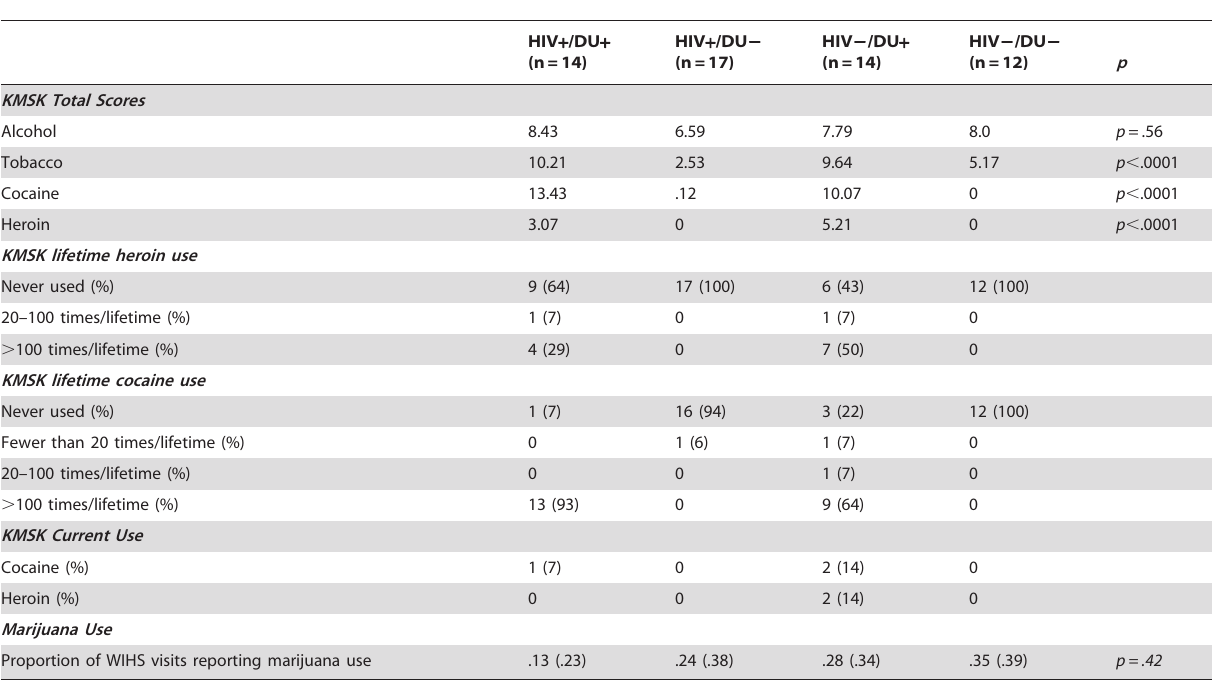
Table 2. Substance use characteristics of